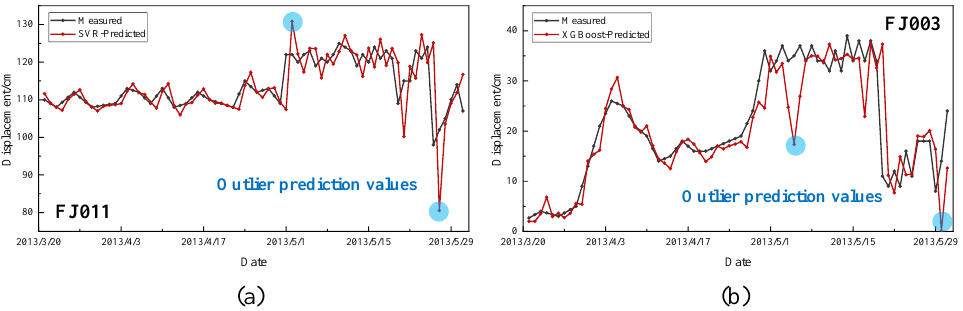
Figure 10. Outlier prediction values of SVR and XGBoost model. ( a ) Outlier prediction values of SVR. ( b ) Outlier prediction values of